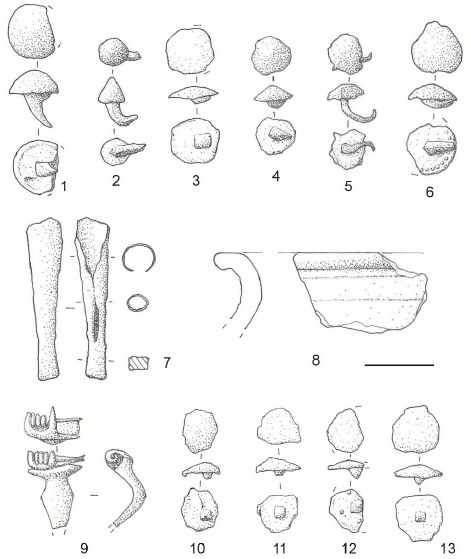
Figure 5. Archaeological materials from road 2 and immediate surroundings. 1 – 3 from area A; 4 – 7 from area B; 8 – 9 found between area B and C (for the finding spot see the star in Figure 3); 10 from area E; 10 – 13 from area I. Scale bar: 2 cm; drawings by A. Fragiacomo.